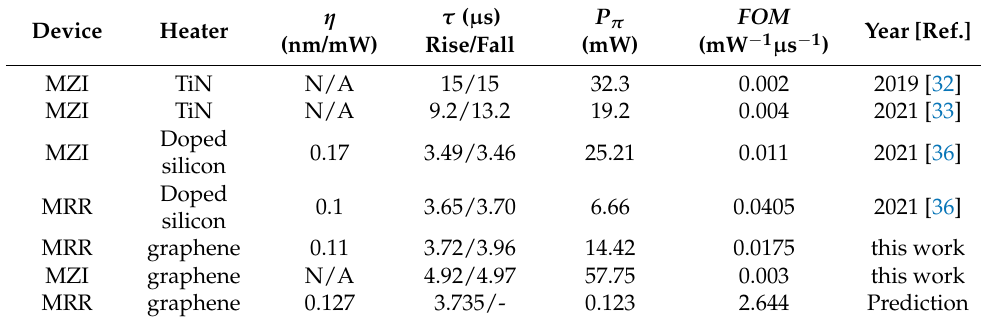
Table 1. Performance comparison of some silicon TO devices working at 2 µ